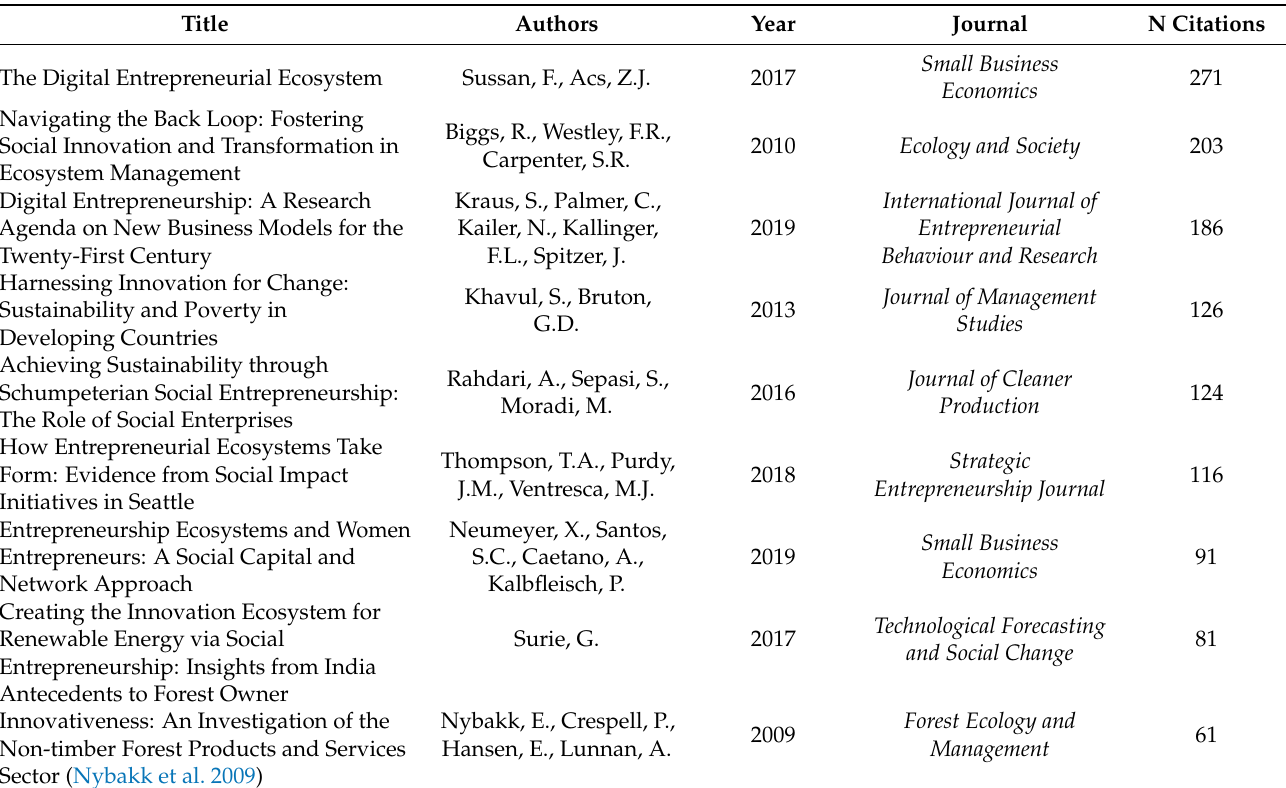
Table 1. The most influential papers on social entrepreneurship and the entrepreneurial ecosystem. Source: own elaboration.